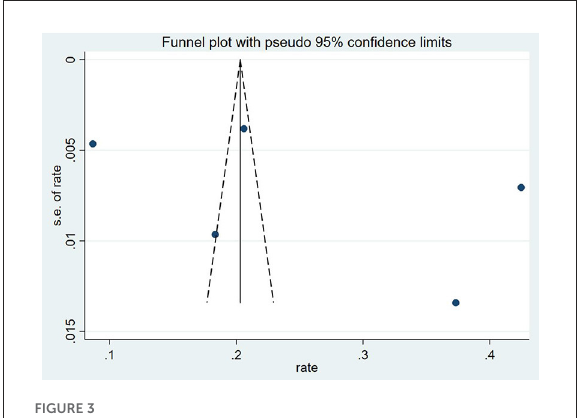
FIGURE3 Funnel figure showing the prevalence of ICUs